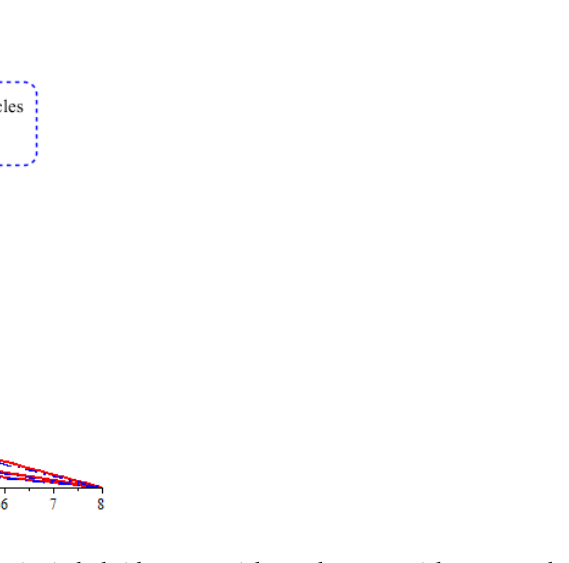
Figure 8. Comparative analysis of velocity in hybrid nanoparticles and nanoparticles versus change in 𝑅𝑒.